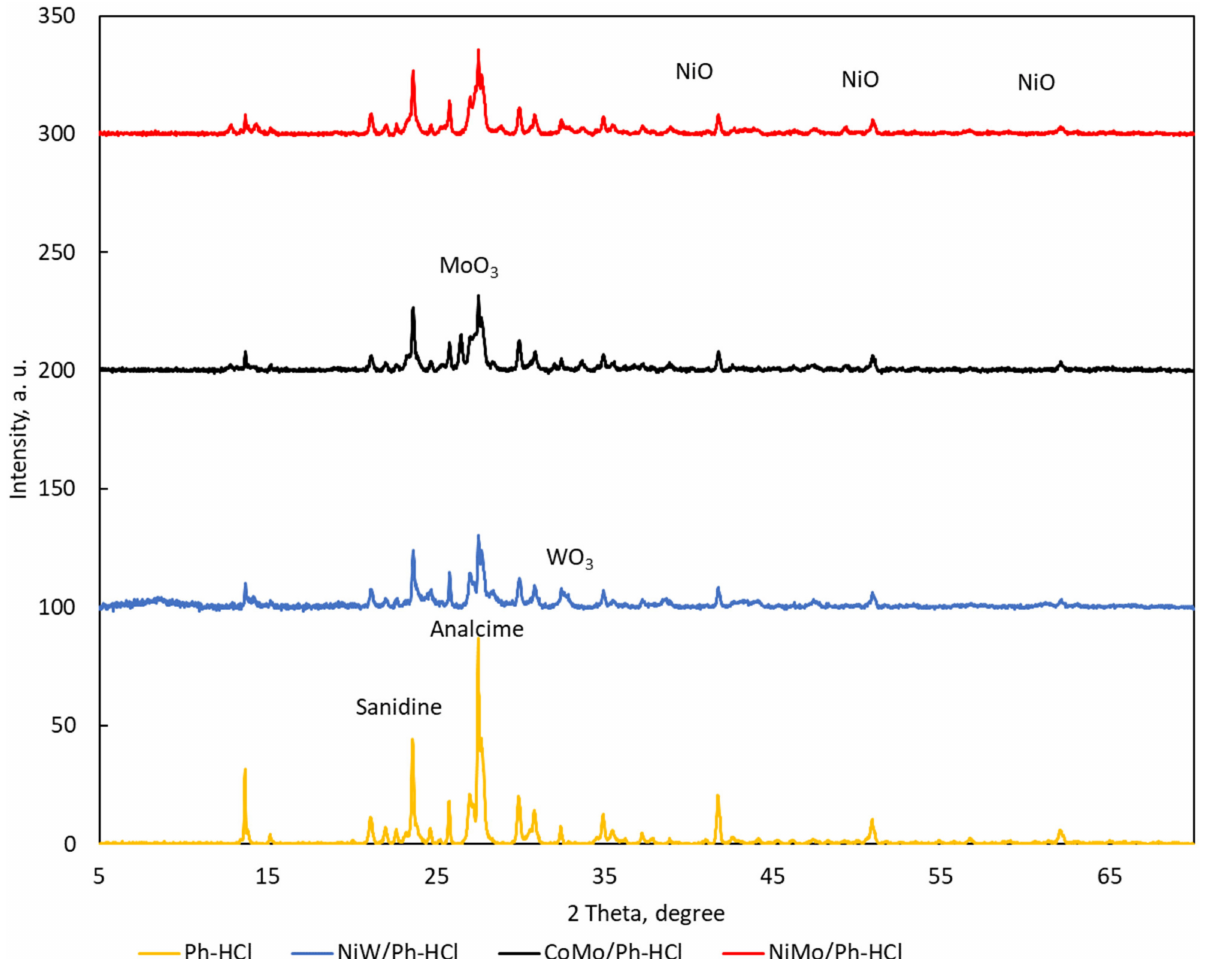
Figure 1. Wide angle X-ray diffraction (XRD) patterns of the Ph solids. Hydrogen temperature-programmed reduction (H 2 -TPR) patterns are shown in Figure